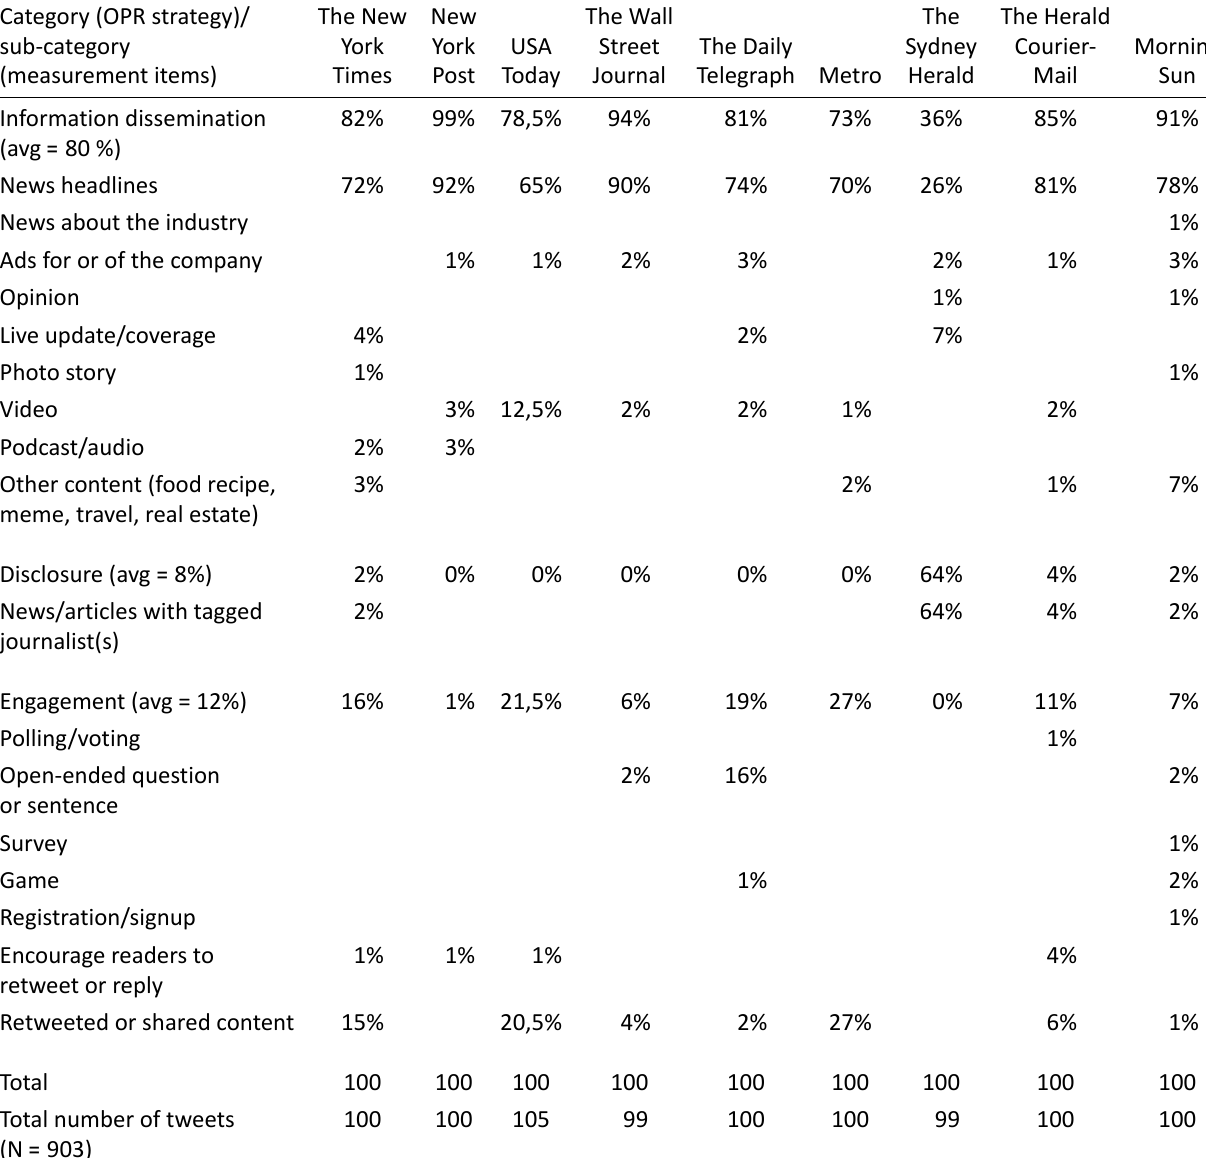
Table 3. The percentage of nine newspapers’ Twitter tweets according to categories and sub‐categories (measurement items) of OPR